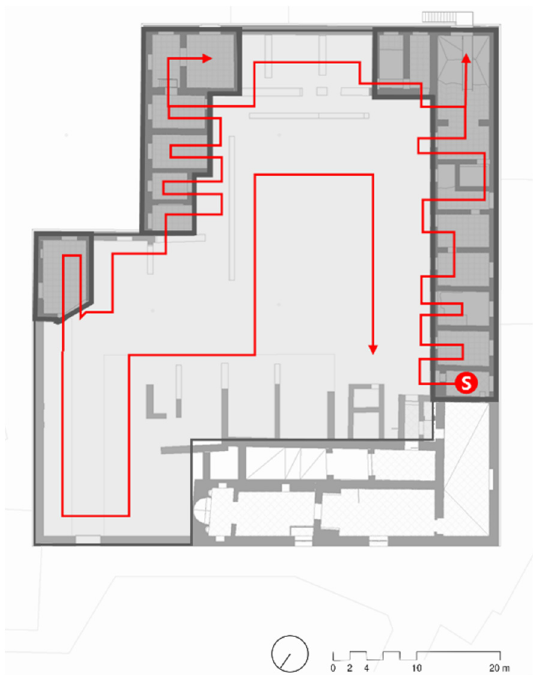
Figure 6. Path of internal and external scans in the area of internal courtyard and internal rooms overlooking it.